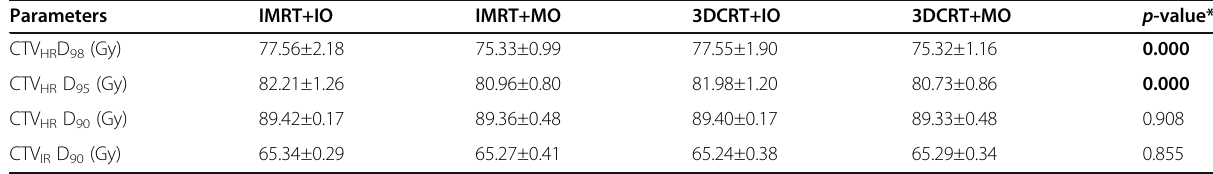
Table 1 The total EQD2 of target volume for different treatment technique